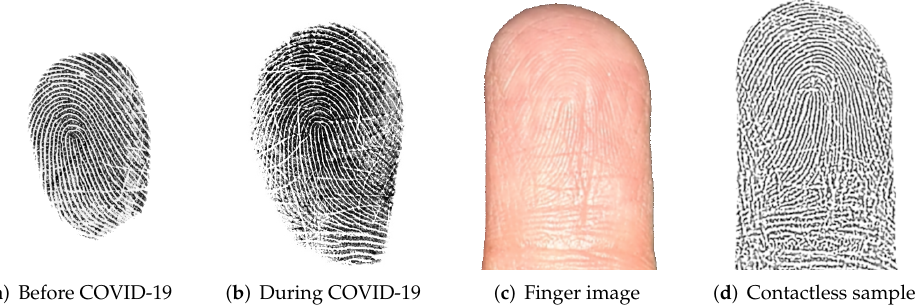
Figure 16. Four samples of the same subject: Sample ( a ) was captured before the COVID-19 pandemic using a contact-based capturing device, whereas samples ( b – d ) were captured during the COVID-19 pandemic. Samples ( a , b ) were captured with the same capturing device, whereas ( c , d ) are captured and processed using our